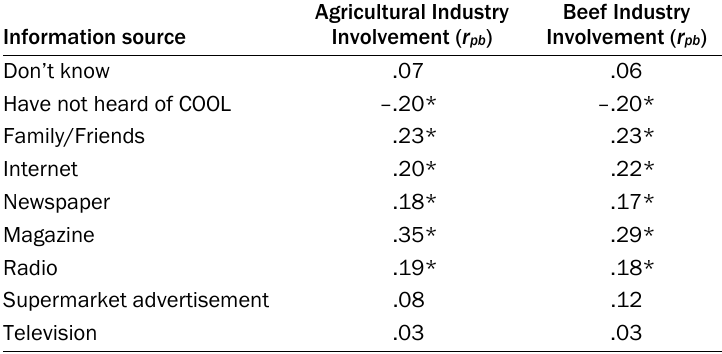
Table 4. Relationships Between Industry Involvement and Information Sources Used for COOL